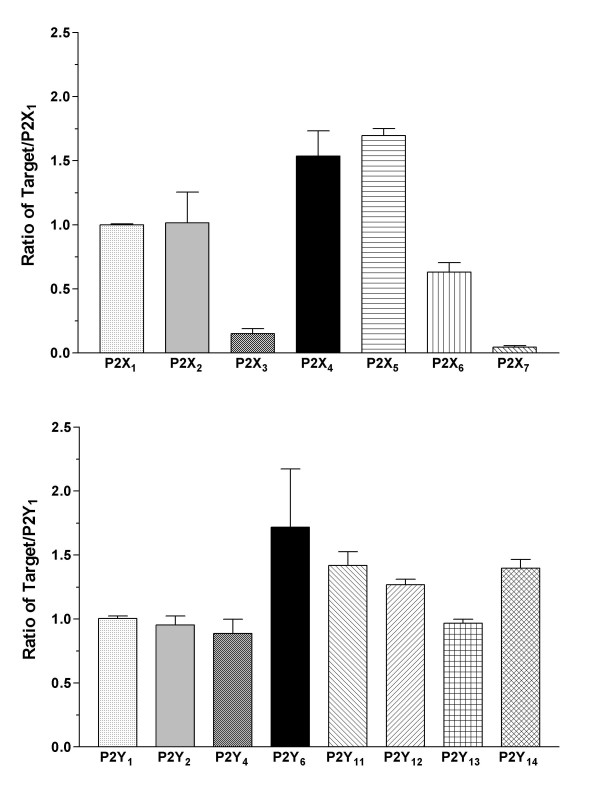
Relative expression of P2 receptors in B cells. The relative expression of the P2X receptor gene (upper; P2X1, P2X2, P2X3, P2X4, P2X5, P2X6, and P2X7) and P2Y receptor gene (lower; P2Y1, P2Y2, P2Y4, P2Y6, P2Y11, P2Y12, P2Y13, and P2Y14) in B cells are presented (n = 4). The expression was normalized to GAPDH. P2X receptors were calibrated by P2X1 and P2Y receptors were calibrated by P2Y1. Data are the mean ± SEM.